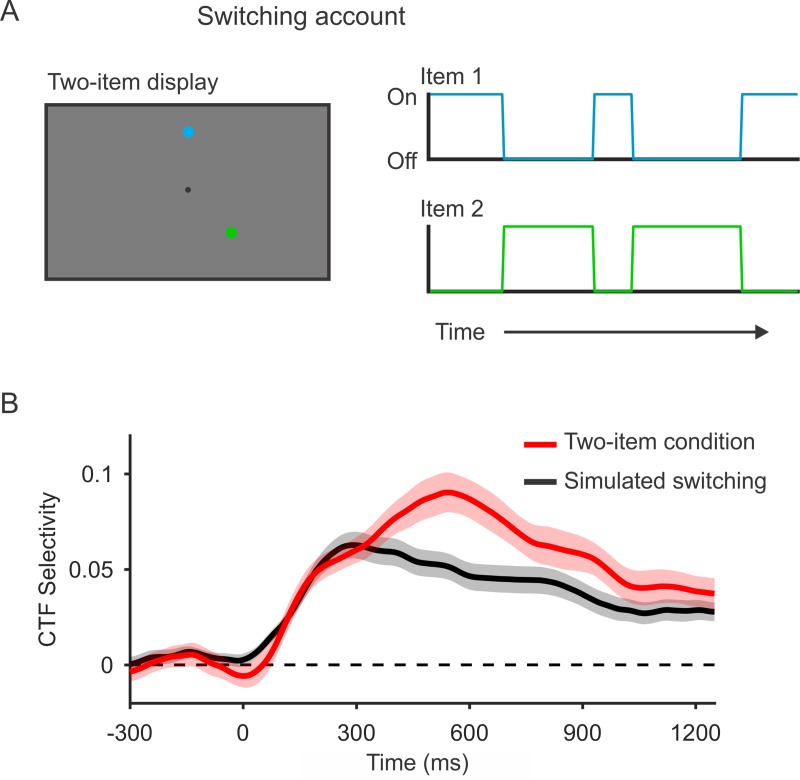
Alpha-band activity concurrently represents 2 spatial positions.(A) If only 1 item can be represented by alpha-band activity at a time, then in the two-item condition, the items might alternate between an active and an activity-silent state such that only 1 item is actively represented at once. We used data from the single-item condition to simulate the expected CTF based on this switching account. This account holds that each item is represented 50% of the time (on average). Thus, we simulated switching between items by randomizing the position labels for 50% of trials for the one-item condition. (B) Spatial selectivity of alpha-band CTFs across time (measured as CTF slope) for the two-item condition (red) and for simulated switching (black). CTF selectivity was reliably higher during the two-item condition (red) than for simulated switching (black). The shaded error bars reflect ±1 SEM across observers. Data are available at https://osf.io/47cmn/. CTF, channel-tuning function.